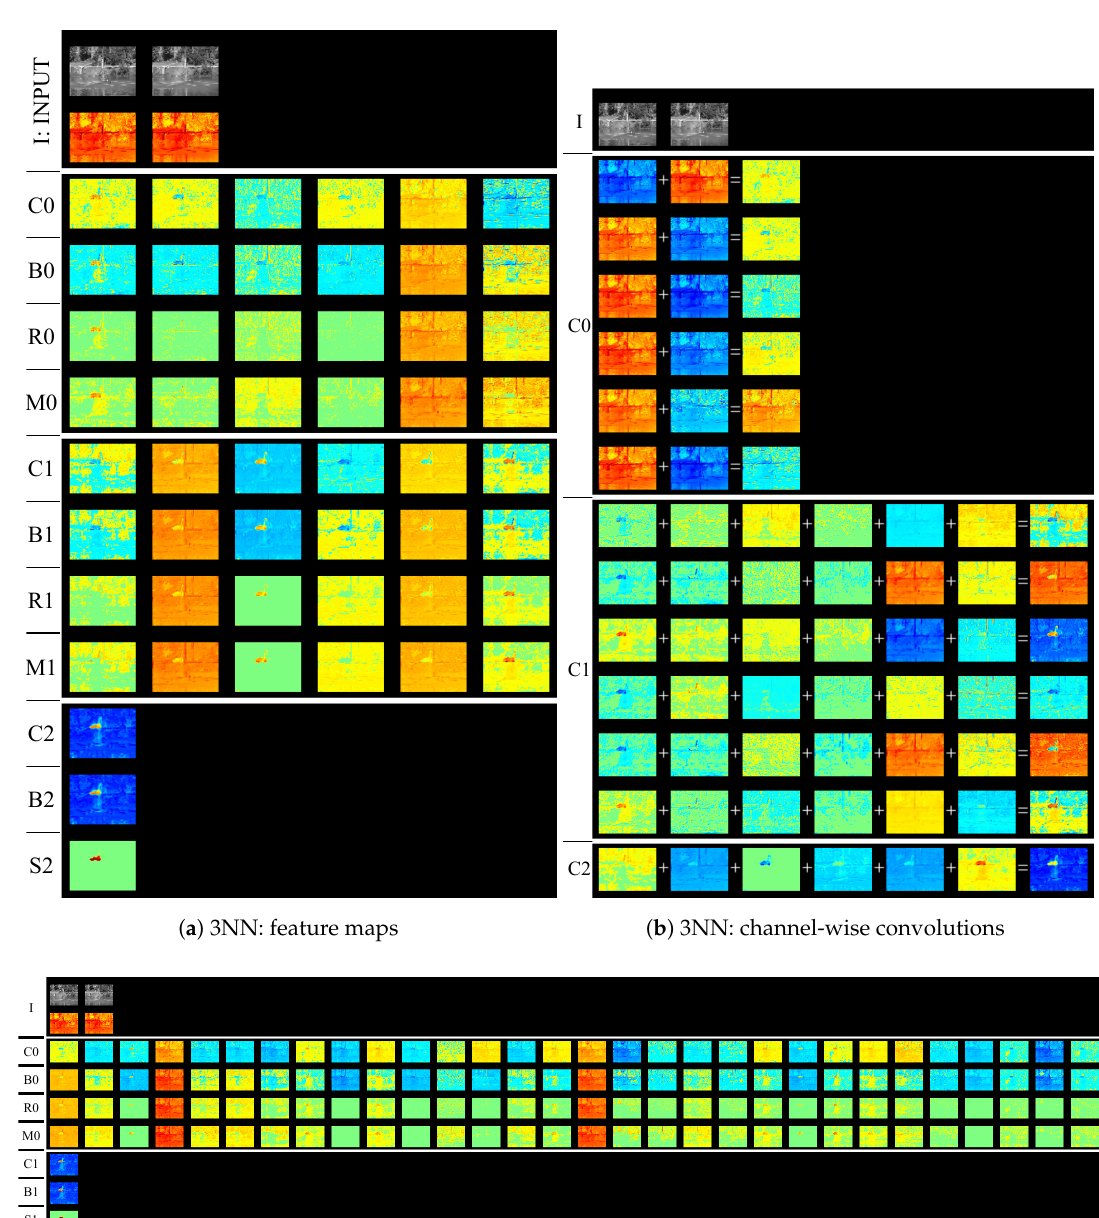
Figure 7. Visualization of feature maps in 3NN and 2NN-large trained on fountain02 sequence. We visualize feature maps in each sub-layer and channel-wise convolution as in Figure 1. The abbreviations C, B, R, S, and M mean convolution, bias, ReLU, sigmoid and max-pooling layer, respectively. Channel-wise convolutions of 2NN-large are excluded because of space